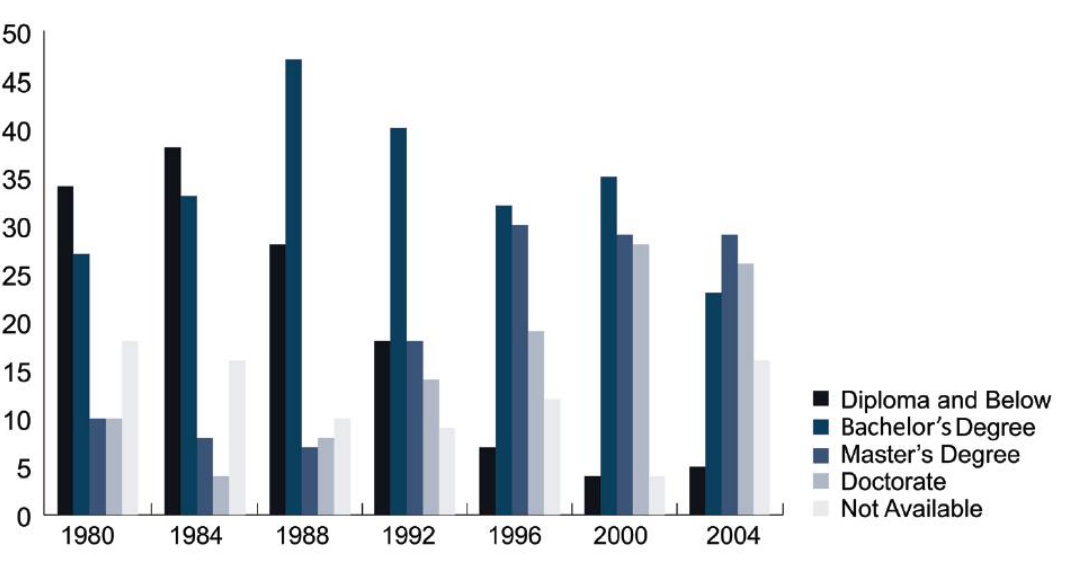
Figure 1: Educational Level of Parliament Members (%), 1980-2004